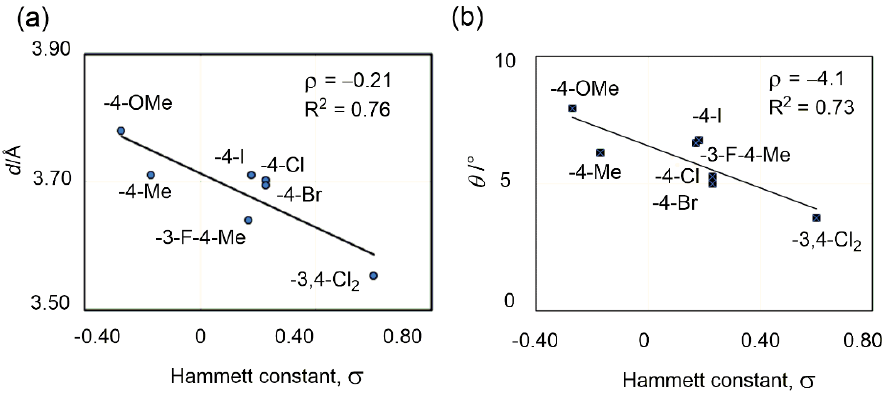
Figure 3. Hammett correlations of ( a ) d and ( b ) θ to σ . Hammett constants were taken from ref. [56] by assuming their additivity.